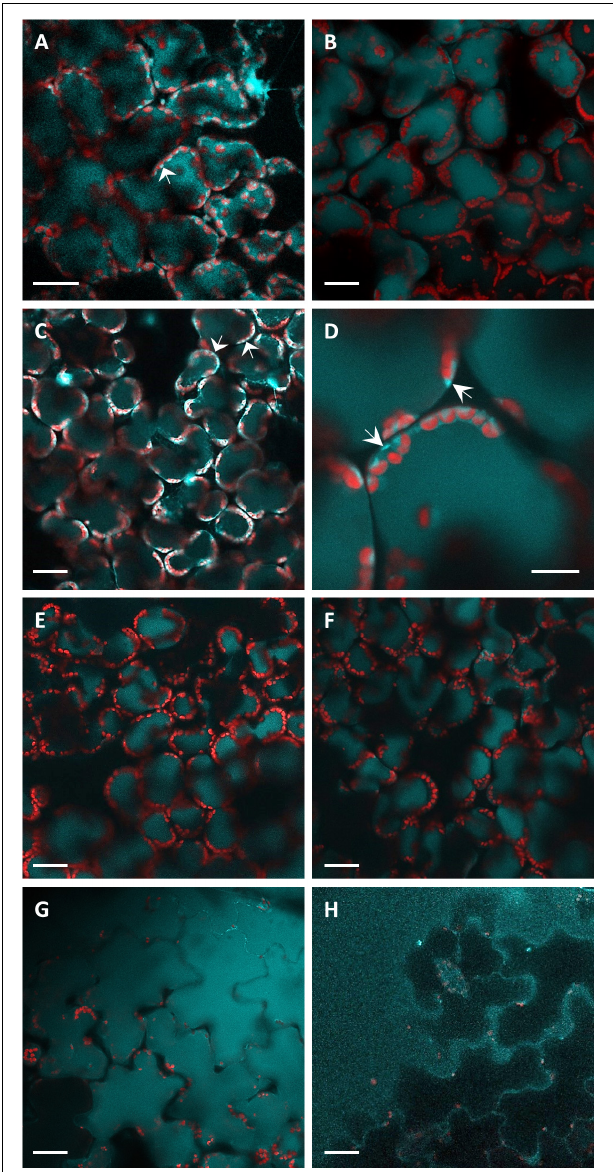
FIGURE 2 | The CLSM fluorescence imaging of leaf disks observed from the adaxial side. Light-blue fluorescence, acquired under excitation at 405 nm and detection at 430–498 nm, represents localization of coumarins. Red fluorescence coming from the chlorophyll of the chloroplasts was acquired under excitation at 638 nm and detection at 695–765 nm. Images were acquired at 9 (A) , 22 (B) , 28 (C,G) , 31 (E,H) , 48 (D) , and 51 (F) hpi. (A–D,G) Report images of P. syringae pv. tomato DC3000 infiltrated leaf disks. (E,F,H) Report the images of SPS-infiltrated leaf disks (controls). The bar in (D) represents 10 µ m, all the other panel bars represent 30 µ m. The arrows indicate the cytoplasmatic localization of blue fluorescence.